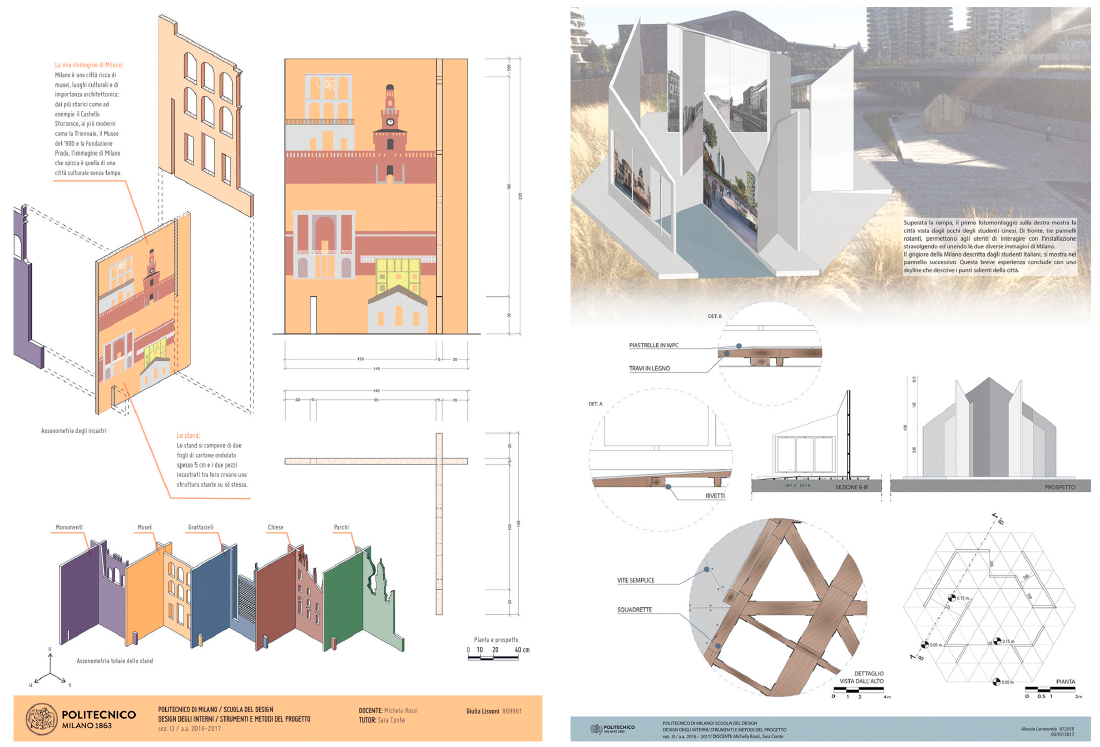
Figure 6. Two projects in which is the city that shows itself. The shape of the most important buildings in Milan is used as booth to exhibit other images of the